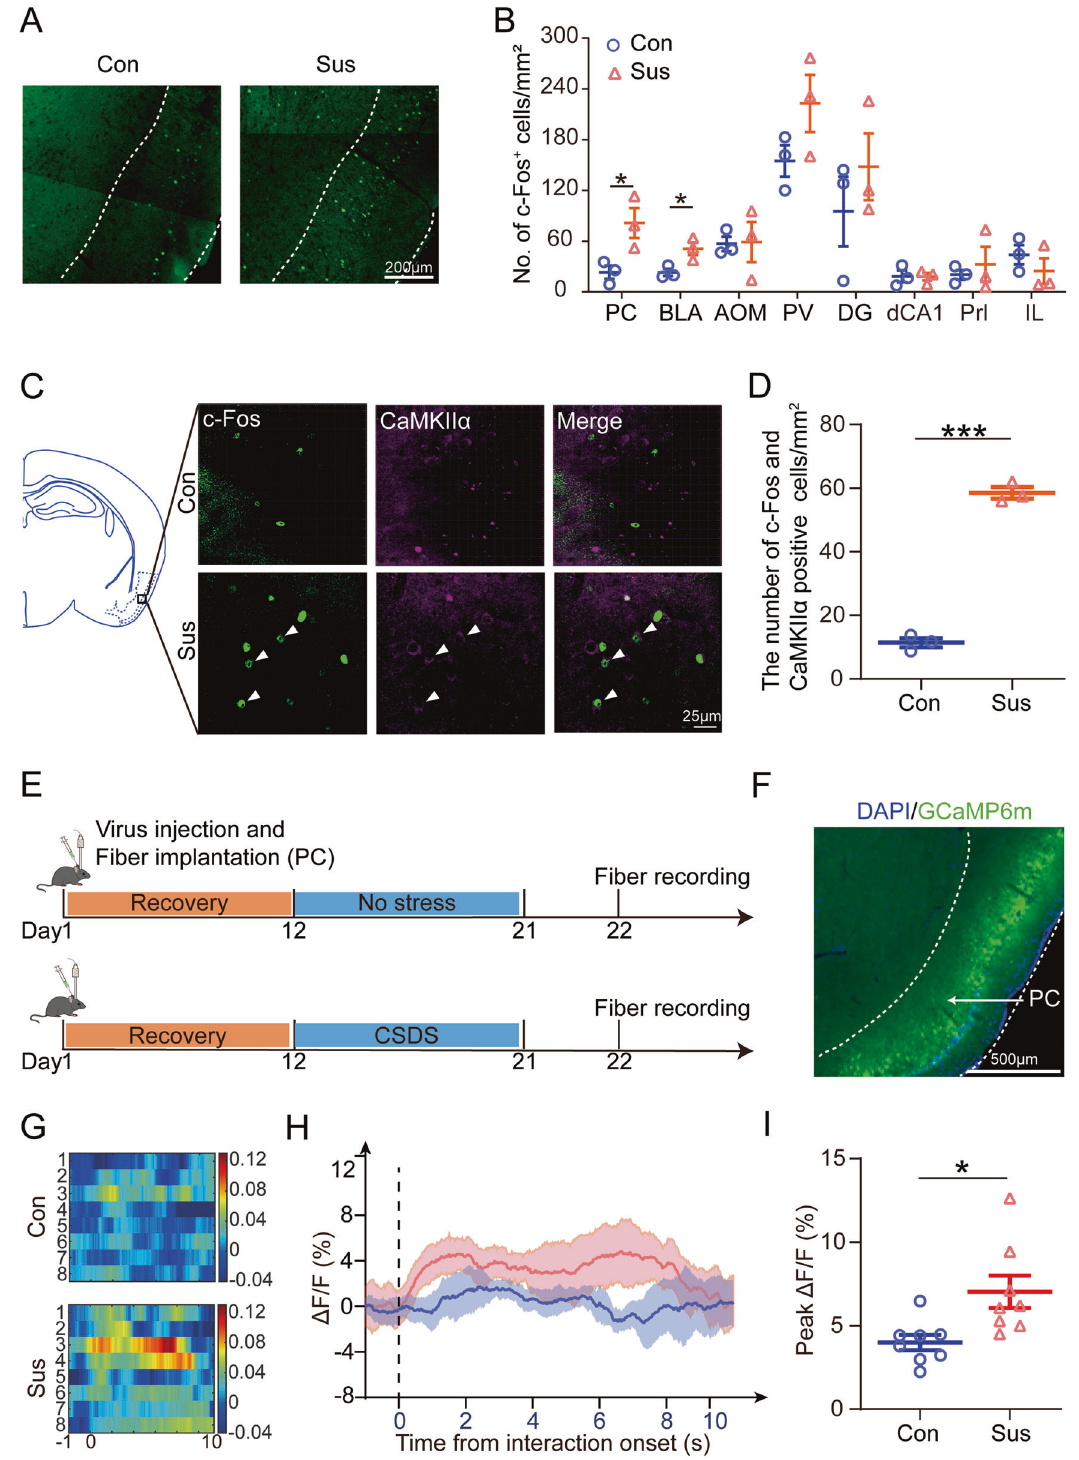
PC of control mice, a small number of c-Fos + and were CaMKII α + co-labeled neurons were found. After CSDS treatment, the density and ratio of CaMKII α + and c-Fos + co-labeled cells increased signi fi cantly, and these double-labeled neurons are distributed in layers I – III of PC, with the most in layer II and less in layers I and III (Fig. 2D and Supplementary Fig. 4A). These results indicate